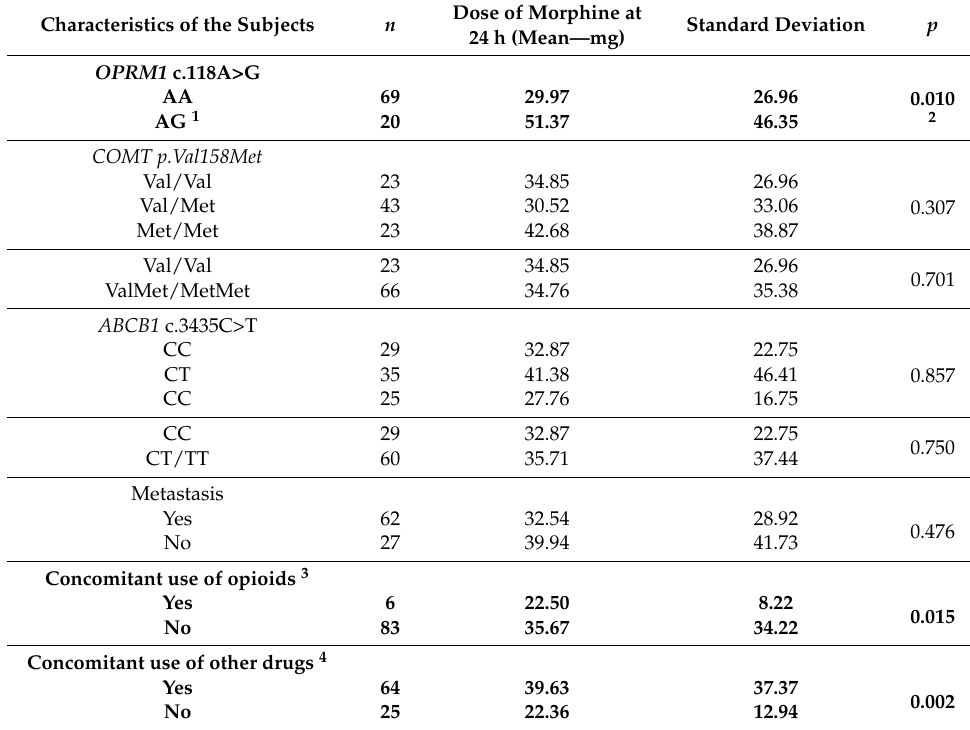
Table 3. Comparisons of some socio-demographic and genetic characteristics between the groups of subjects differing in morphine dose at 24 h.